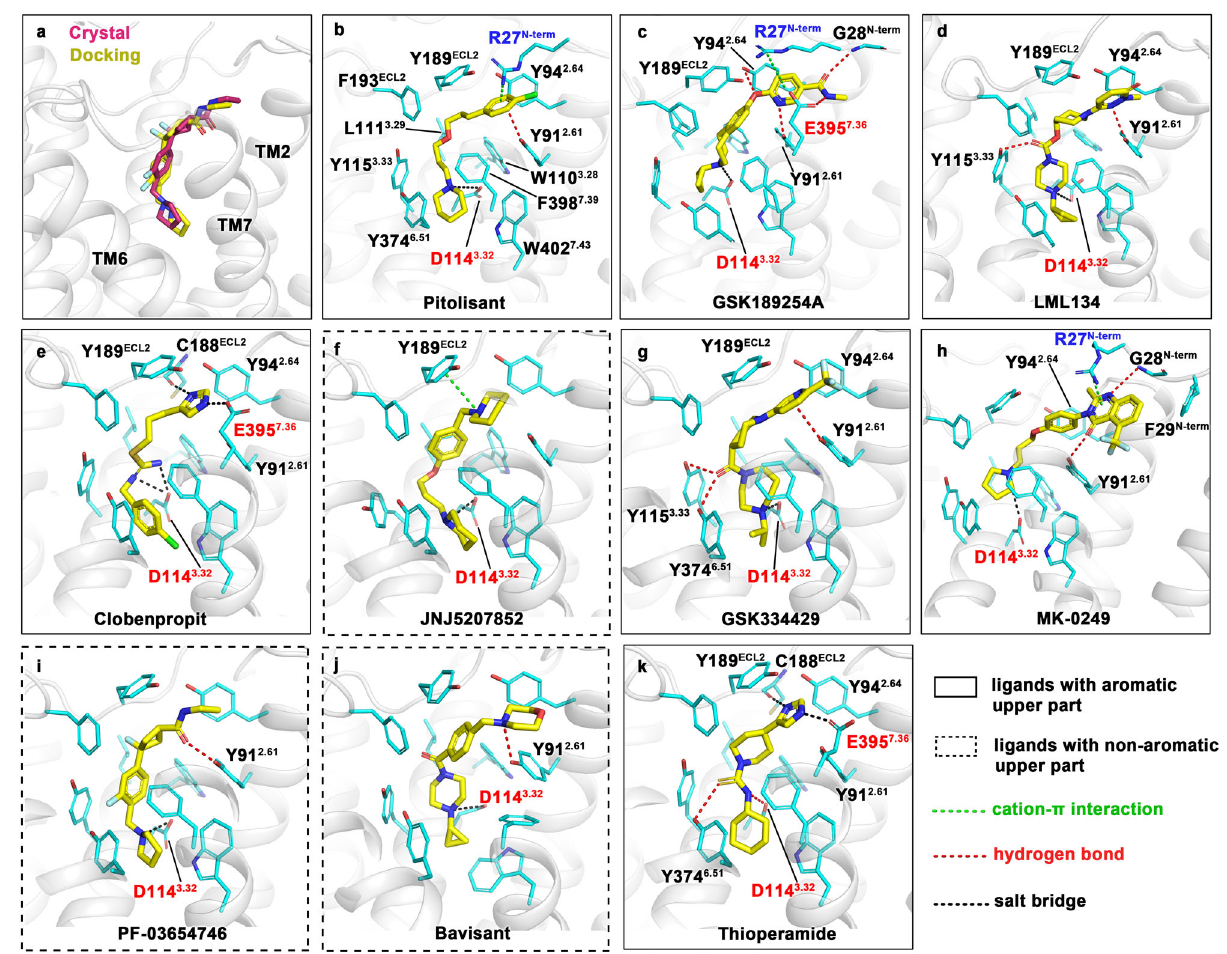
Fig. 3 | Docking results of PF-03654746 and nine different H3R antagonists. a Superimposition of PF-03654746 in the crystal structure (magenta) and the docked pose (yellow). b – k Binding modes of 10 H 3 R antagonists. The docked ligands were depicted as yellow sticks and arranged according to their K i values from low to high as shown in Supplementary Table 2. Ligands with an aromatic moiety in the upper part of their binding poses were boxed with solid lines and ligands with non-aromatic upper parts were marked with dash